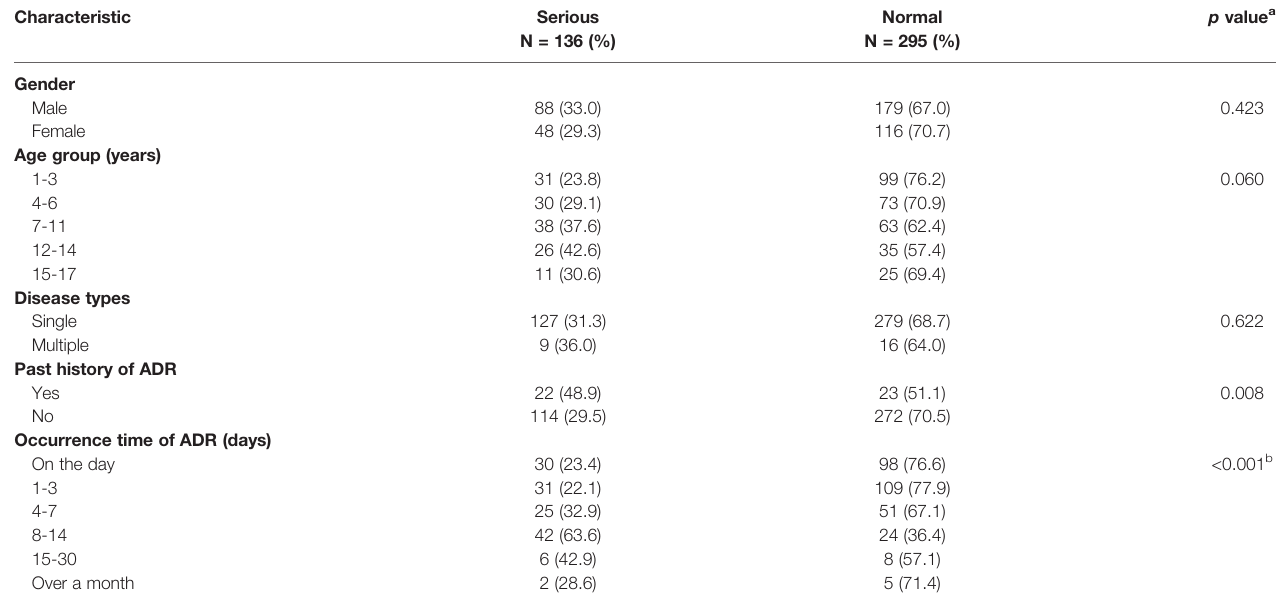
TABLE 2 | The characteristics of patients aspect by severity of ADR. Characteristic